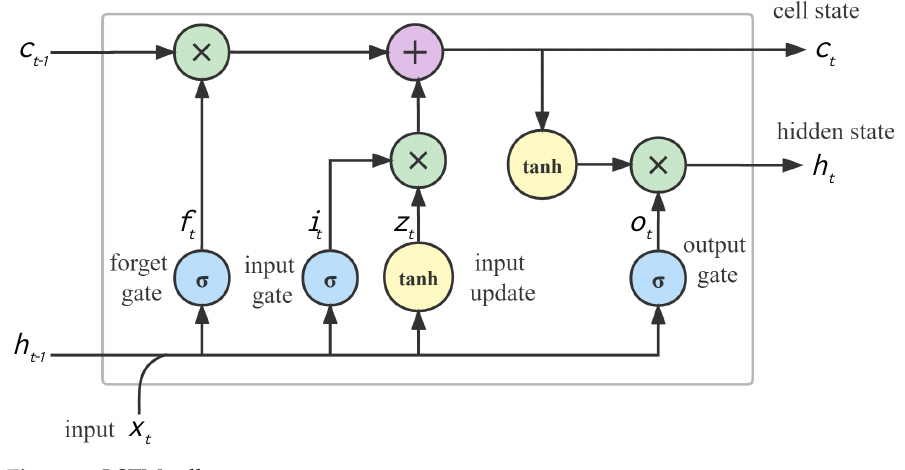
Figure 4. LSTM cell